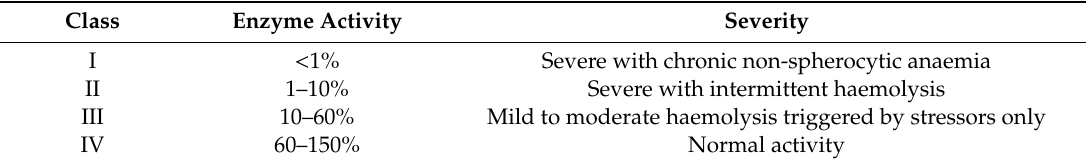
Table 1. Classification of glucose-6-phosphate dehydrogenase deficiency (G6PDD) with respect